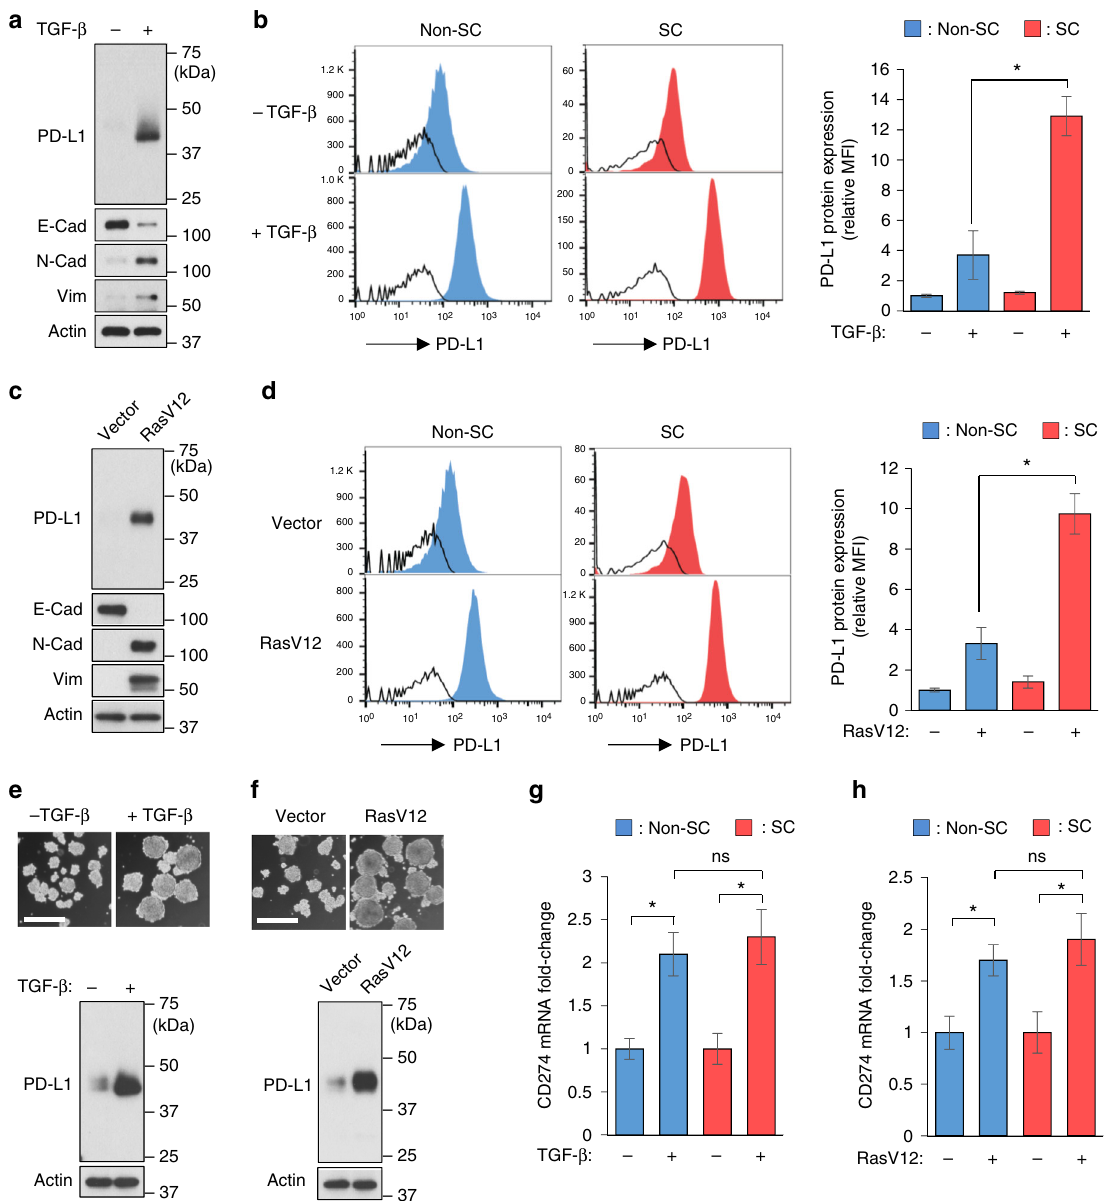
Fig. 1 EMT induces a more robust upregulation of PD-L1 protein in CSCs than in non-CSCs without signi fi cant induction of PD-L1 mRNA levels. a , c Western blot analysis of PD-L1 and EMT markers in the general cell population of MCF-10A cells undergoing EMT driven by TGF- β ( a ) or RasV12 ( c ). E-Cad E- cadherin, N-Cad N-cadherin, Vim vimentin. b , d Flow cytometric analysis of PD-L1 protein expression in breast stem-like cell (SC) (CD44 + CD24 − /low , red histograms) and non-SC (non-CD44 + CD24 − /low , blue histograms) populations from control cells and EMT cells driven by TGF- β ( b ) or RasV12 ( d ). Open histograms represent isotype IgG negative control. The mean fl uorescence intensity (MFI) of each cell population was quanti fi ed by FlowJo and compared. e , f Representative phase-contrast microscopy images and PD-L1 expression of spheres growing from control or EMT cells driven by TGF- β ( e ) or RasV12 ( f ). Scale bar, 200 μ m. g , h qRT-PCR analysis comparing PD-L1 (CD274) mRNA induction levels between SC (CD44 + CD24 − /low ) and non-SC (non-CD44 + CD24 − /low ) populations upon TGF- β ( g ) or RasV12 ( h ) treatment. Error bars represent s.d. ( n = 3). * P < 0.05; ns: non-signi fi cant, Student ’ s t -test. See also Supplementary Fig.